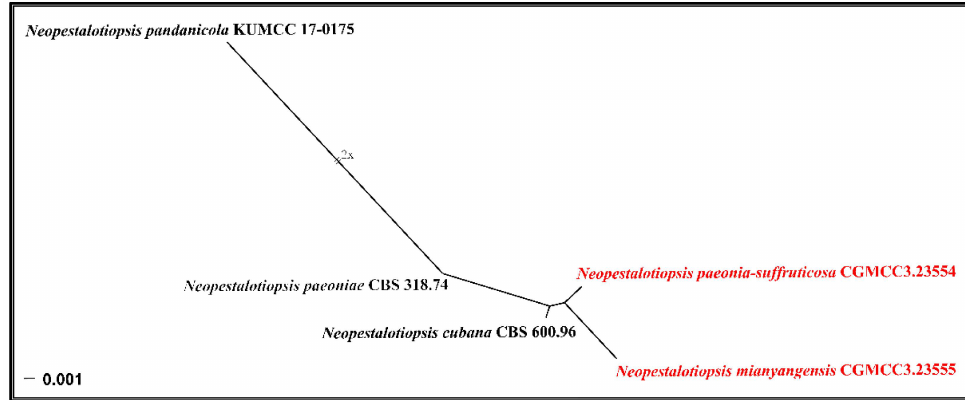
Figure 6. Split graphs showing the results of PHI test of Neopestalotiopsis mianyangensis and N. paeonia- suffruticosa with their most closely related species (Fw = 0.2781). The new taxa are shown in red. 3.2.2. Neopestalotiopsis paeonia-suffruticosa W.L. Li and Jian K. Liu., sp. nov . (Figure